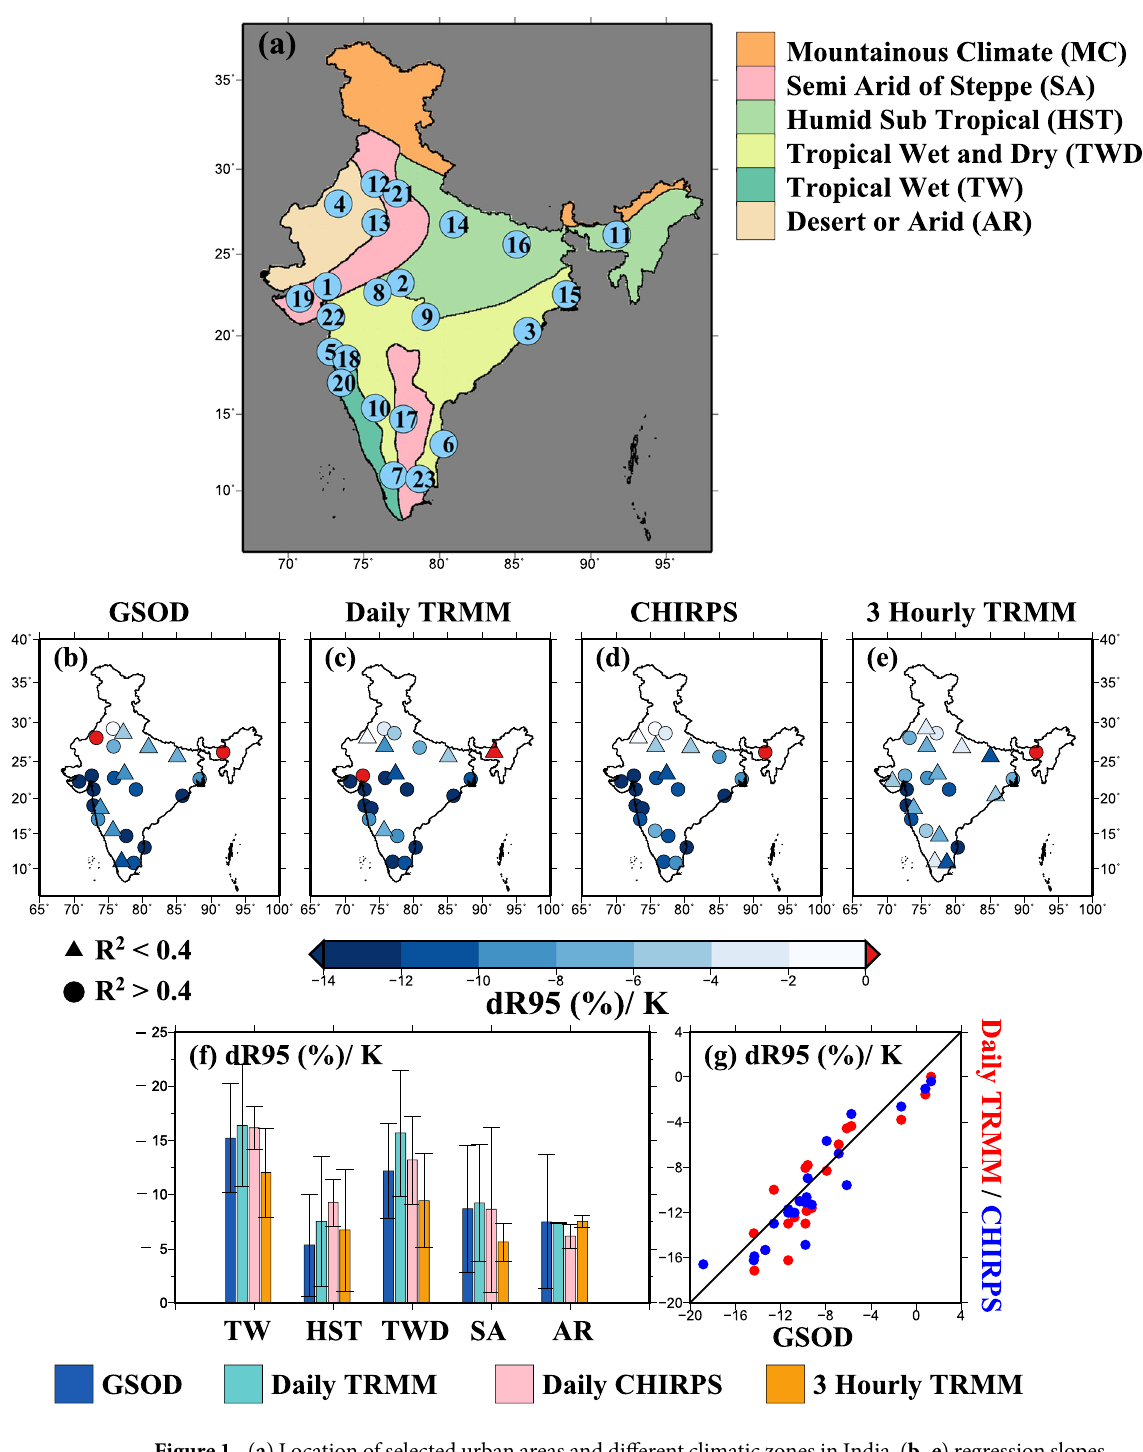
Figure 1. ( a ) Location of selected urban areas and different climatic zones in India, ( b – e ) regression slopes (dR95/K, %) obtained from daily GSOD, daily TRMM, daily CHIRPS and 3-hourly TRMM data, respectively with surface air temperature (SAT) using quantile regression (QR) at the 95th percentile for 23 urban areas across India, ( f ) regression slopes (dR95/K) from daily GSOD (blue), daily TRMM (cyan), daily CHIRPS (pink) and 3-hourly TRMM (orange) data for different climatic zones respectively where bars denote mean values and whiskers show standard deviations, ( g ) agreement in scaling results between GSOD and Daily TRMM (red) and GSOD and CHIRPS (blue), pooled for all 23 urban areas. The figure was developed using the Generic Mapping Tools (GMT, https://www.soest.hawaii.